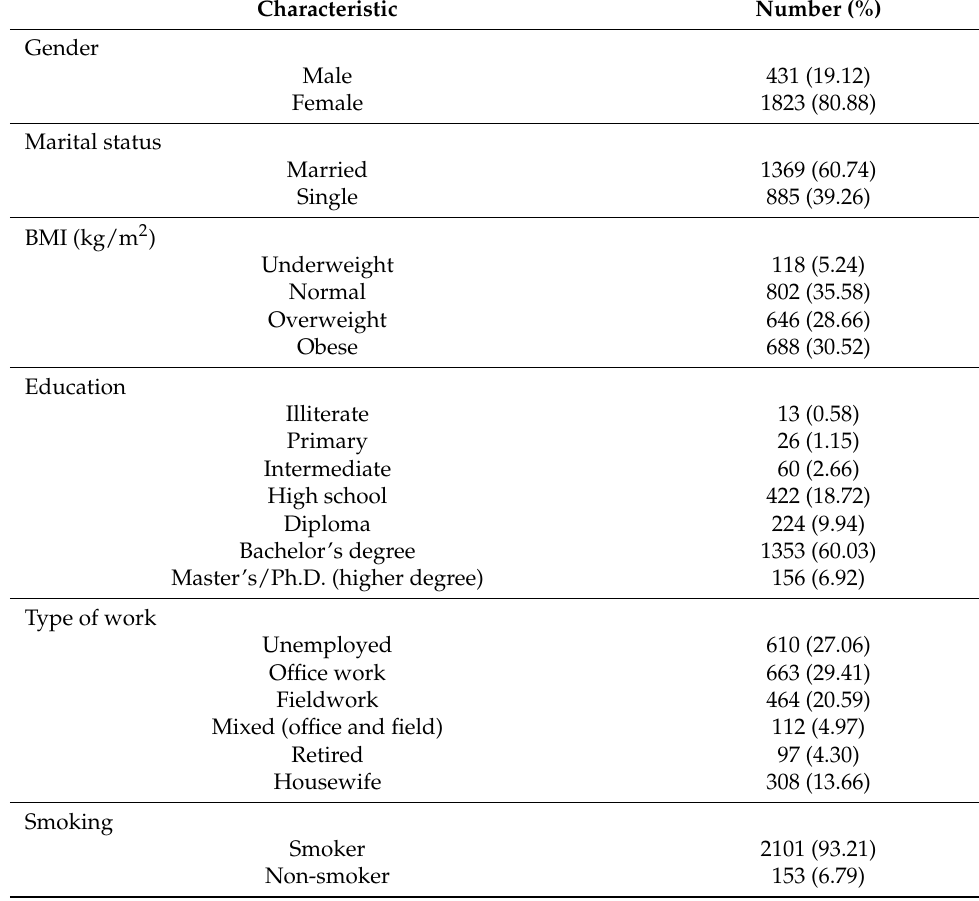
Table 1. Characteristics of the respondents (n = 2254) included in the study. Characteristic Number